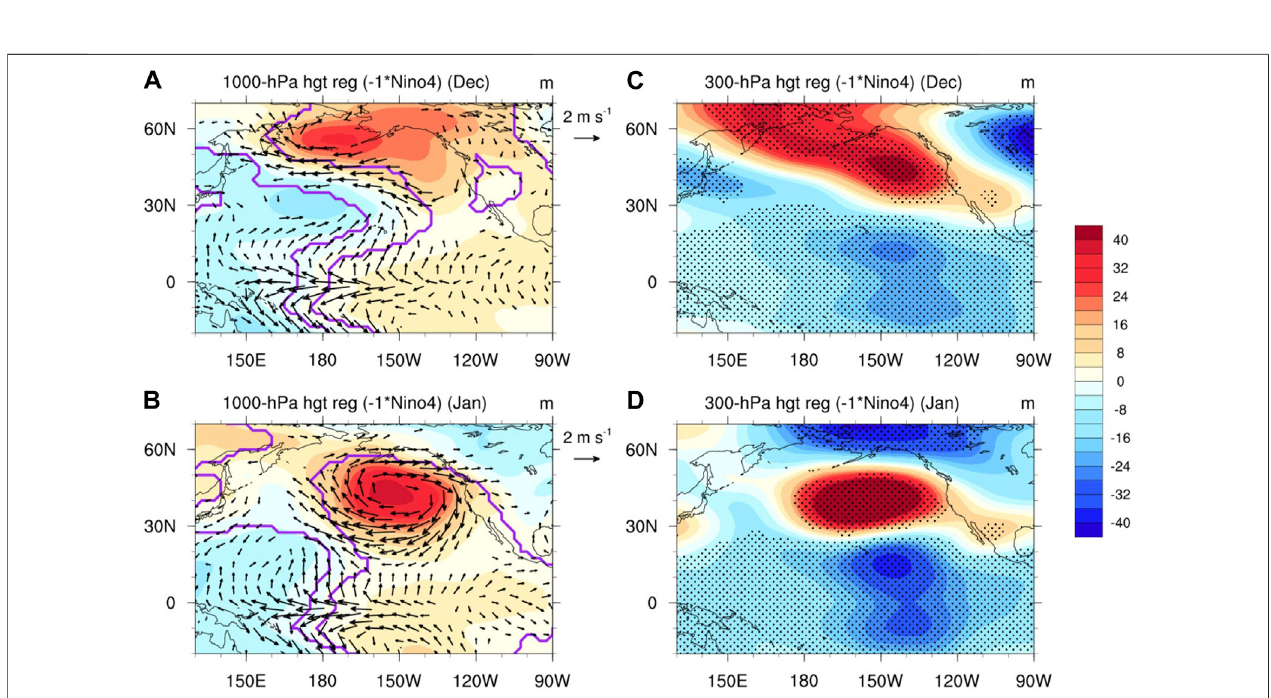
FIGURE 7 | Regressions of the December (A) 1,000 hPa geopotential height (shading; m) and winds (vectors; m s − 1 ), and (C) 300 hPa geopotential height (shading;m)ontothe − Niño4fortheperiod1979 – 2017overthePaci fi c (B,D) Asin(A,C)butforJanuaryduring1980 – 2018.Anomaliessigni fi cantatthe95%con fi dence level are denoted by dots and purple contour lines, and vectors represent the anomalous winds signi fi cant at the 95% con fi dence level, as estimated by the Student ’ s t -test.